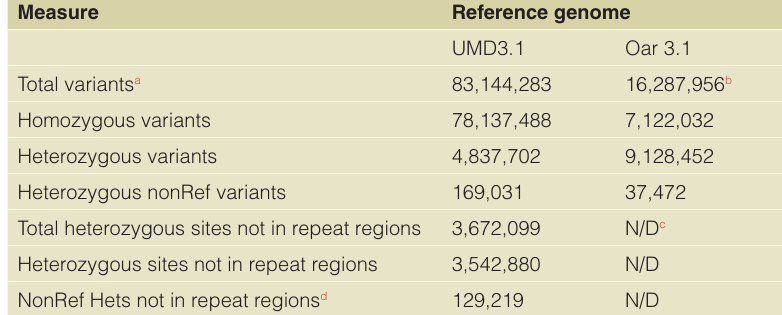
Table 3. Genome-wide variants identified in reference